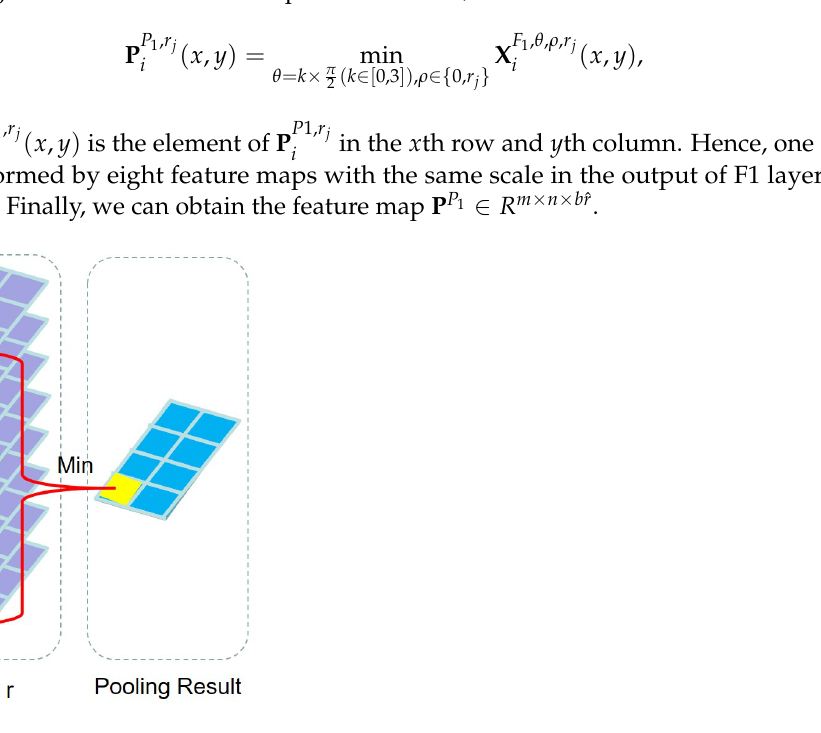
Figure 5. MIN pooling on the r th scale corresponding to band i . For the i th band, each scale can produce one feature